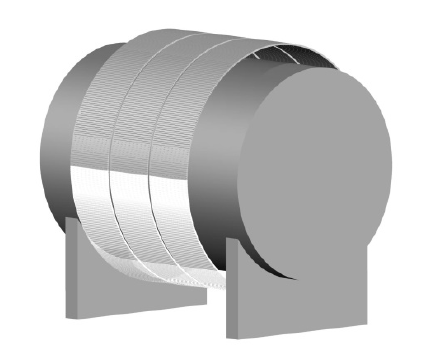
Figure 4. Conceptual design of the MCORD detector surrounding the MPD detector at the NICA